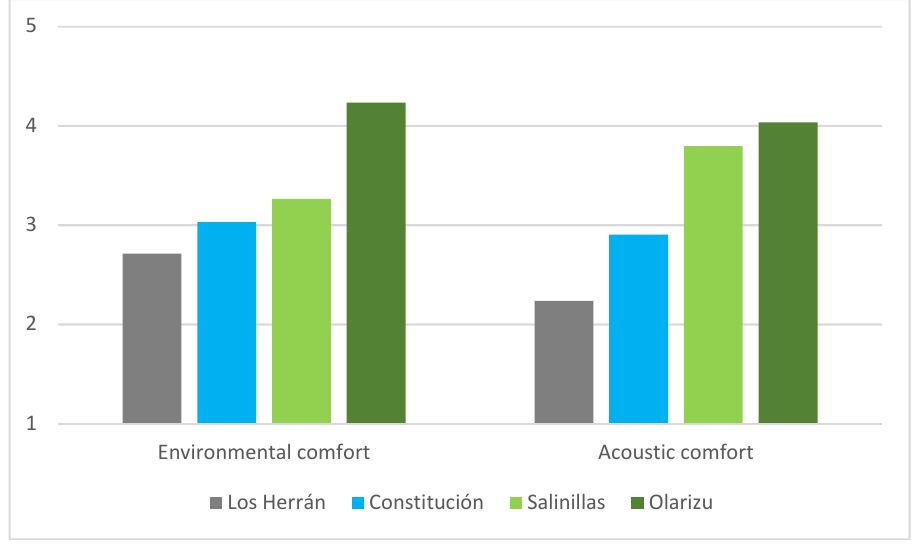
Figure 4. Mean scores for environmental and acoustic comfort in relation to the artificial-natural continuum.